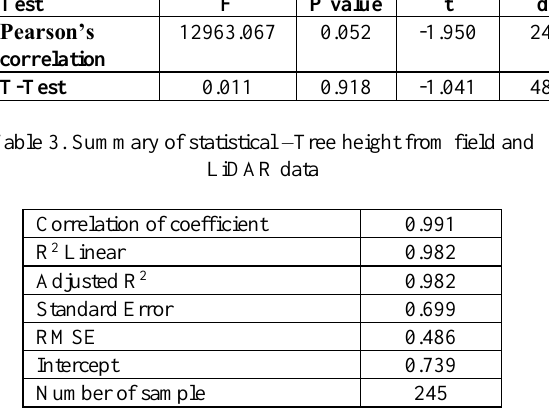
Table 4. Overall summary of fit